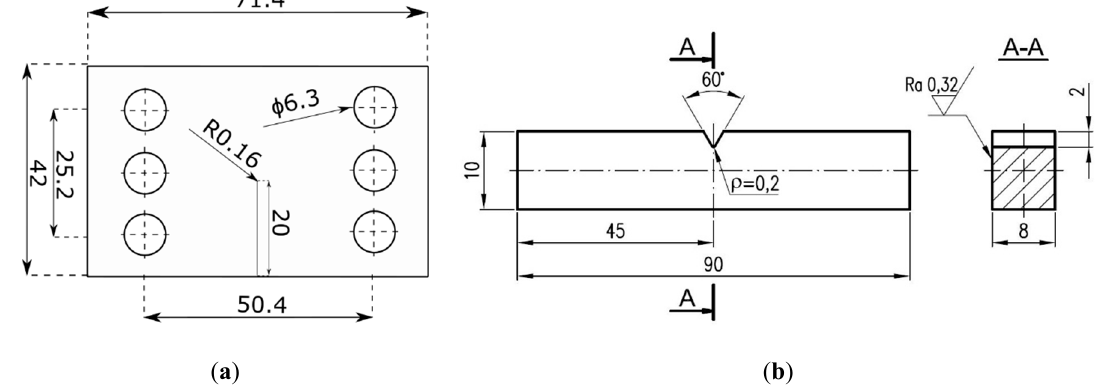
Figure 3. Geometry and dimensions (in mm) of specimens used in both the experimental and numerical campaign: ( a ) CTS (Compact Tension Shear) specimen (thickness—8 mm); ( b ) specimen subjected for mode I + III testing.